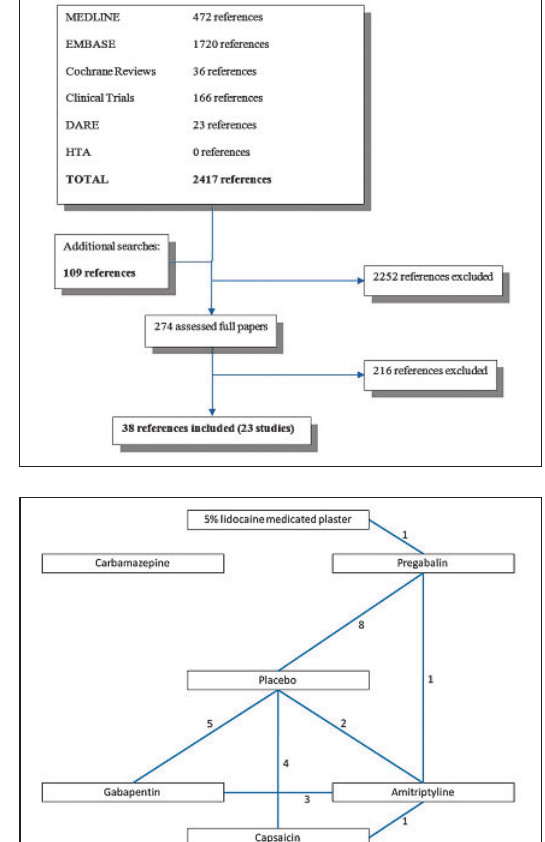
Flow diagram of systematic review to identify eligible studies.